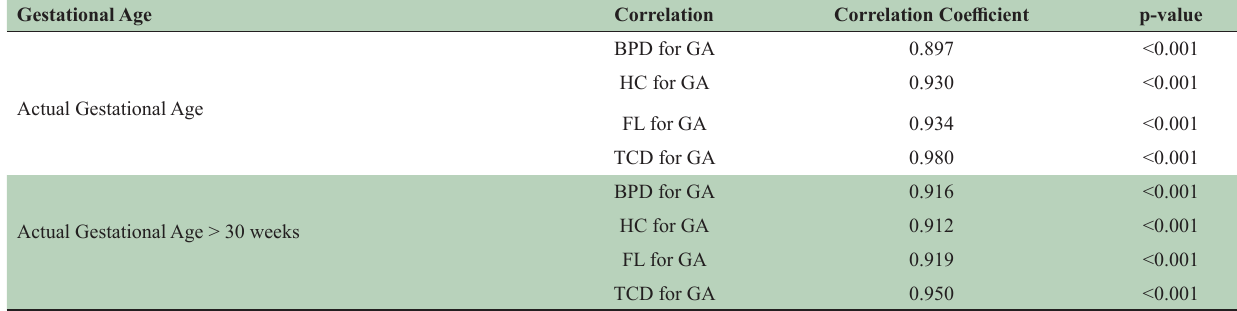
Table III: Correlation of TCD and routinely used parameters with gestational